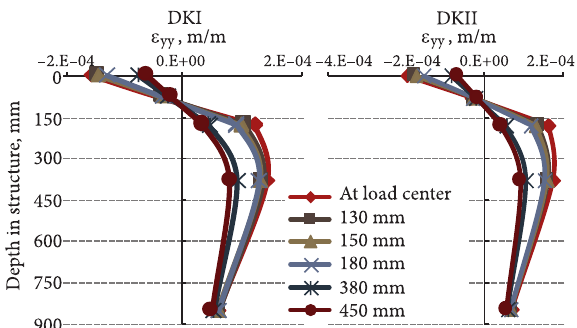
Fig. 8. The limit according to subgrade layer resistance to permanent